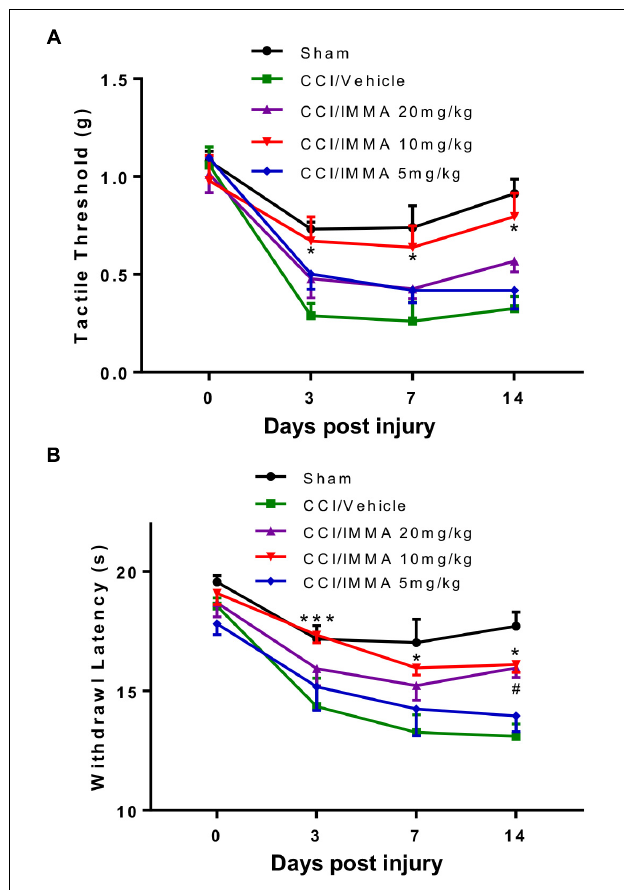
FIGURE 1 | IMMA dose dependently alleviated neuropathic pain in CCI mice. At days 0, 3, 7, and 14 after surgery, mechanical tactile thresholds were evaluated by the “Up-Down” method using Von Frey filaments (A) and thermal withdrawal latency was determined by Hargreaves test (B) . Treatment with IMMA at 10 mg/kg significantly reduced thermal withdrawal latency and increased mechanical thresholds compared to the vehicle group ( ∗ p < 0.05 and ∗∗∗ p < 0.001. n = 15/group). At 5 mg/kg, IMMA had no effect, although there was a trend toward the increased tactile threshold and withdrawal latency. Treatment of IMMA at 20 mg/kg significantly increased thermal withdrawal latency only on day 14 compared to the vehicle group ( # p < 0.05. n = 15/group). Data were analyzed using two-way ANOVA, and the Tukey-Kramer post hoc test was used for comparing different treatment